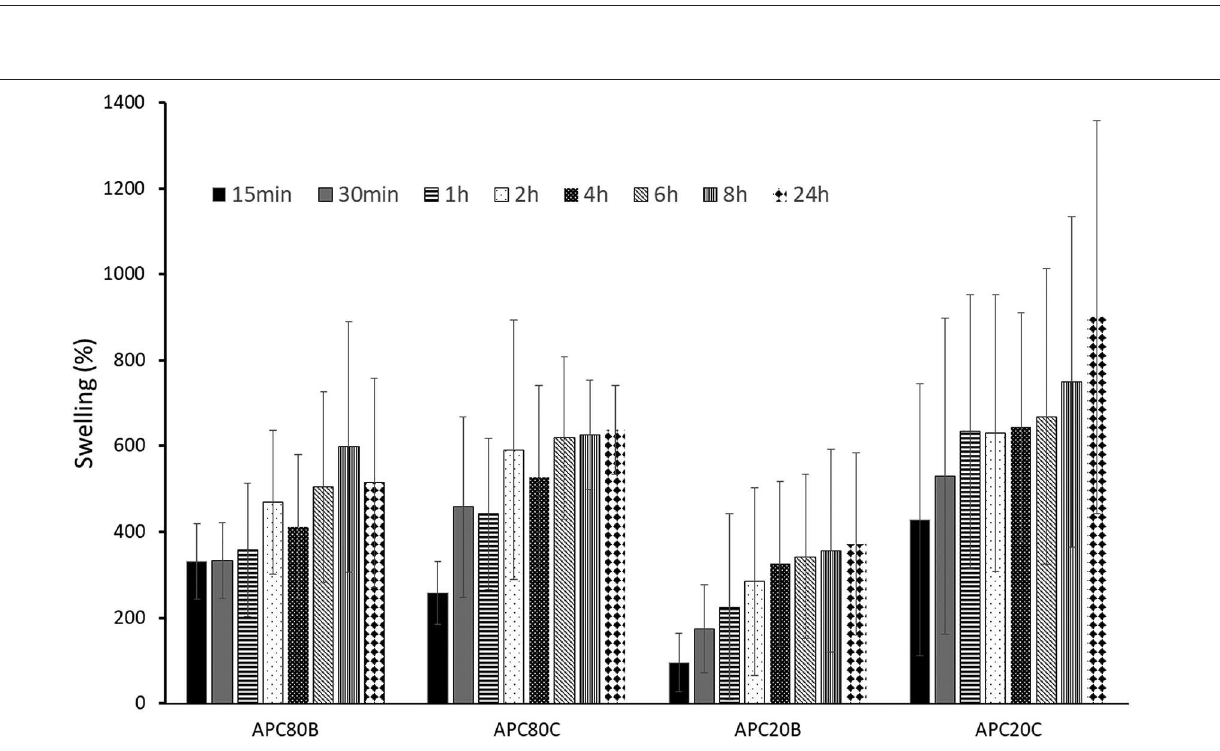
Frontiers in Materials |